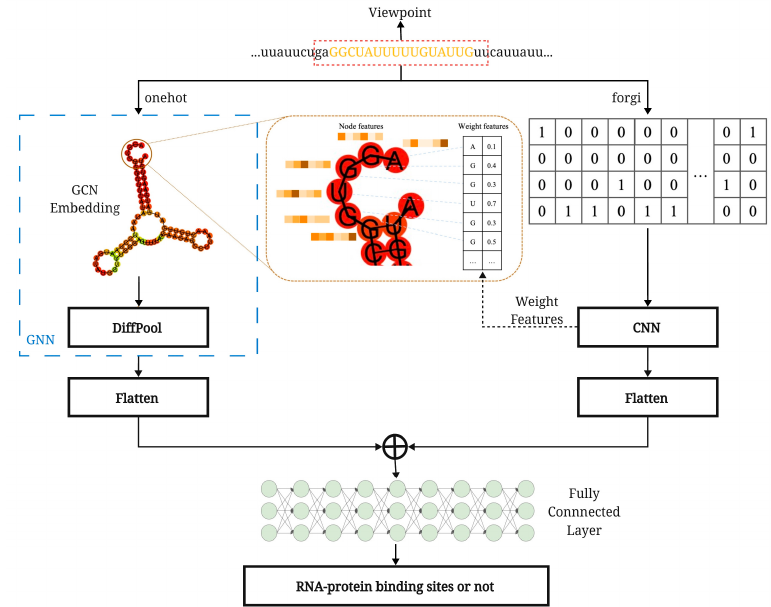
Figure 1. Overall structure diagram of HPNet architecture.